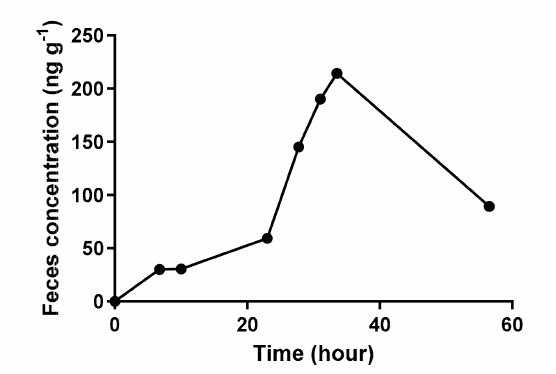
Figure 2. Fecal concentrations of ceftiofur-related residues, measured as desfuroylceftiofuracetamide, in fecal samples of one female pig (pig n ◦ 2) following intramuscular administration of 3 mg · kg − 1 body weight of ceftiofur.